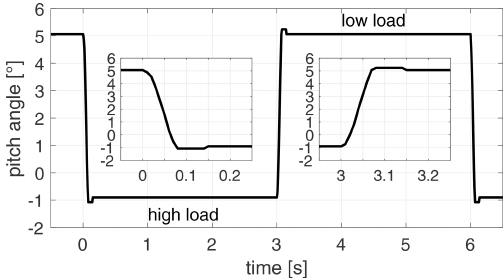
Figure 3. Pitch motor encoder signal for a pitch step to high load followed by a step to low load with additional zoomed-in views of the actual pitch steps.